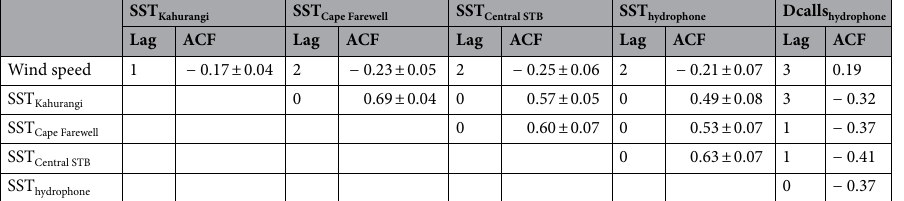
SST Kahurangi SST Cape Farewell SST Central